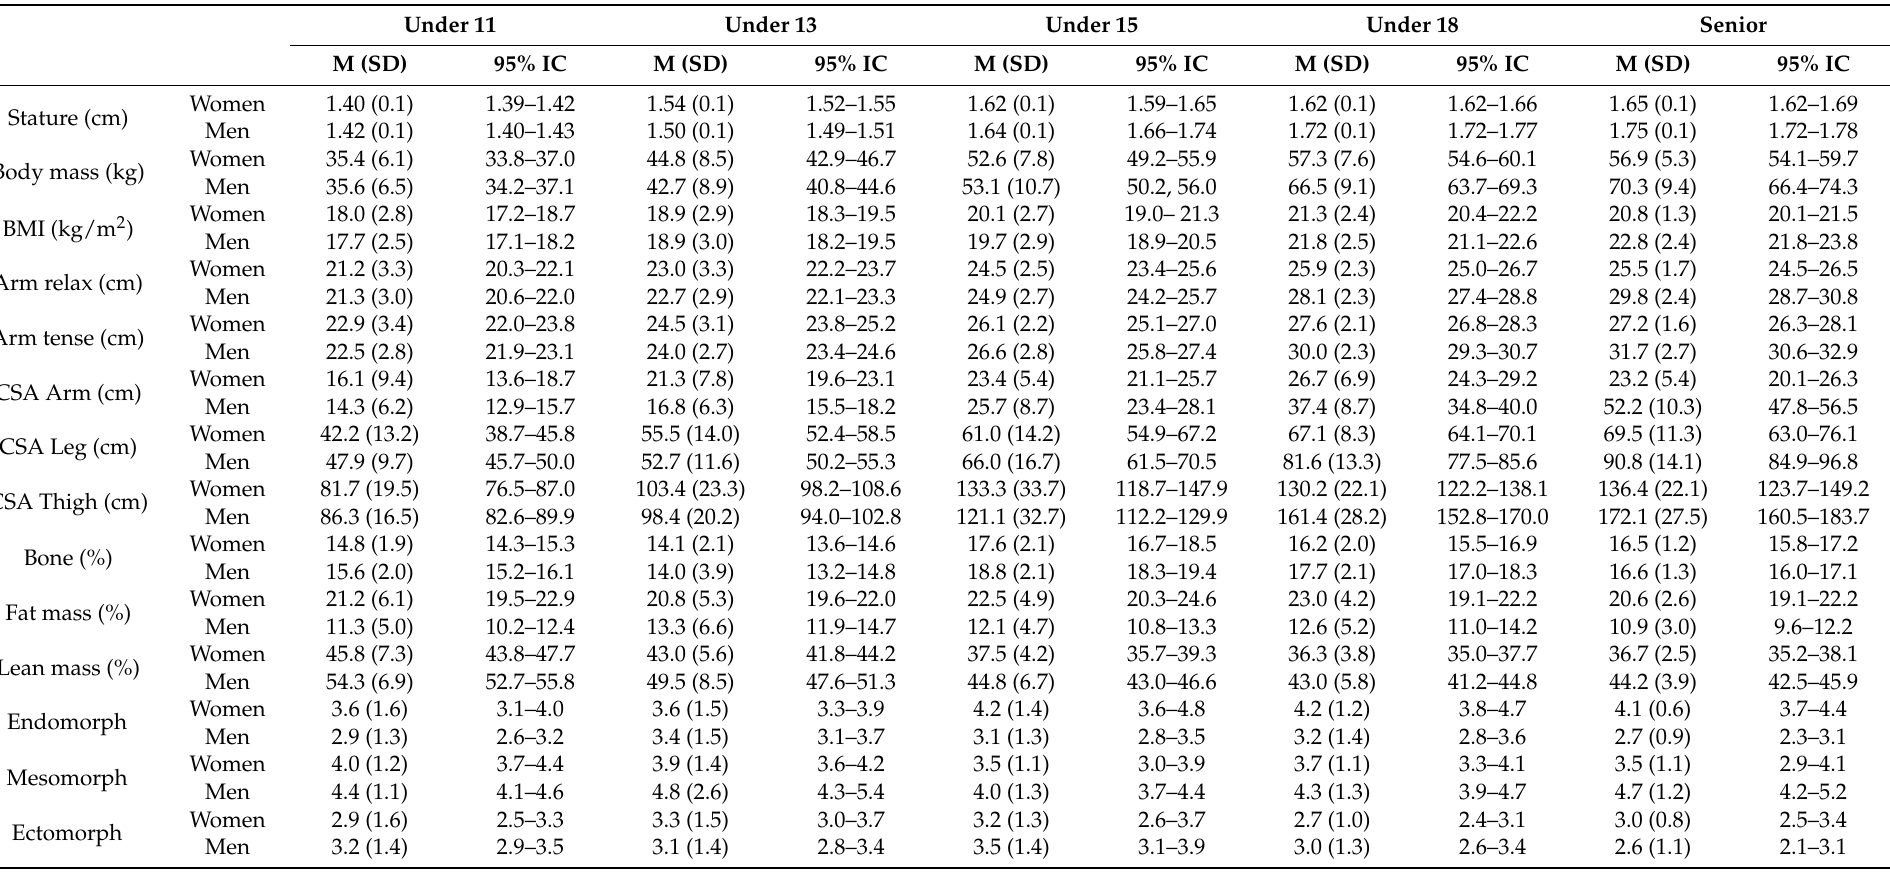
Table 1. Morphological characteristics of high-level table tennis players for sex and age (n = 495). Under